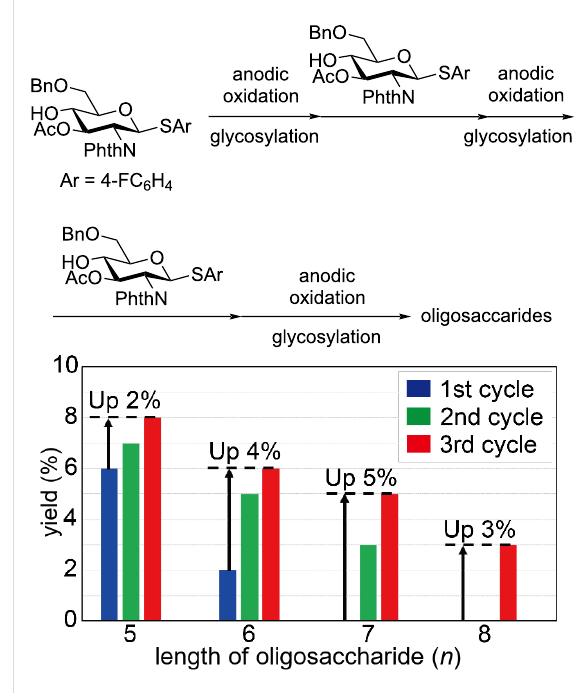
Figure 9: Influence of cycle number on the yield of longer oligosaccha- rides 5a ( n = 5)– 8a ( n = 8). Conditions of anodic oxidation: constant current (8.0 mA, 0.52 F/mol), temperature − 60 °C for anodic oxidation and − 30 °C for glycosylation, building block 1a (0.20 mmol, 109 mg) per cycle as 0.2 M solution in dry CH 2 Cl 2